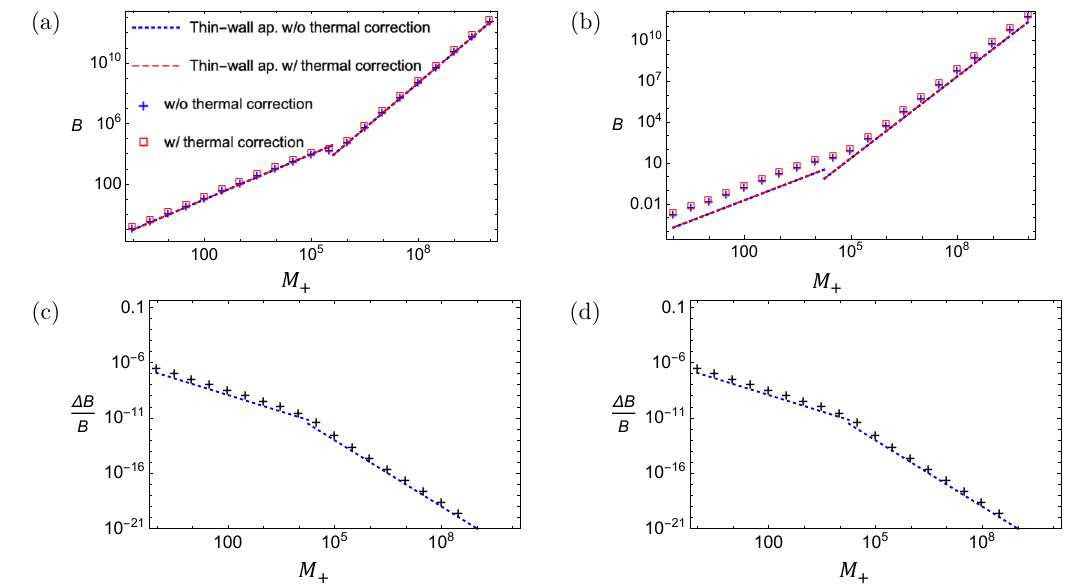
Figure 7 . Figures (a) and (b) show the bounce actions as functions of seed BH mass with the thin-wall ((cid:1) g = 0 : 04) and thick-wall ((cid:1) g = 0 : 88) cases, respectively. We set (cid:21) = ~ (cid:21) = 4 (cid:25) and m = 1 : 45 10 (cid:0) 5 . The approximate analytic formulae of the Euclidean action with/without the (cid:2) thermal correction (red dashed/blue dotted) are also plotted in (a) and (b). For the explicit forms of the analytic formulae, see eqs. (2.52), (3.15) and (3.18). The values of numerically obtained Euclidean actions with and without the thermal correction are plotted with the blue crosses and red squares, respectively. The di(cid:11)erences of the bounce actions with and without the thermal correction are shown in (c) and (d) with the black crosses, along with the thin-wall approximation formulae (eqs. (3.15) and (3.18)) with the blue dotted lines. vacuum to the AdS true vacuum, which is catalyzed by a BH with a mass M + . 10 7 if